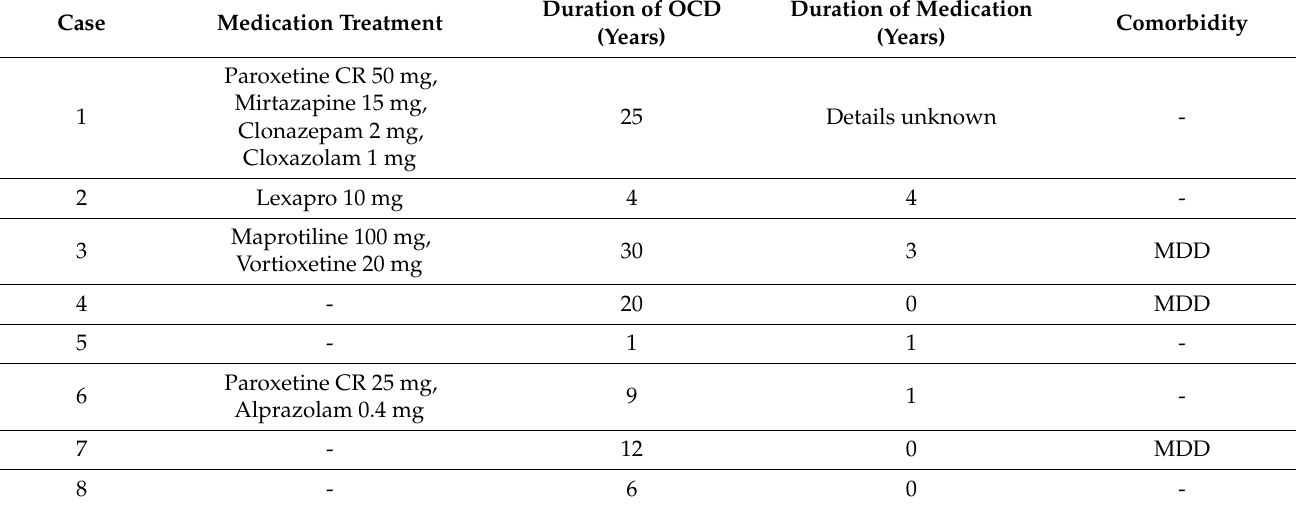
Table 2. Medication and Clinical information of included